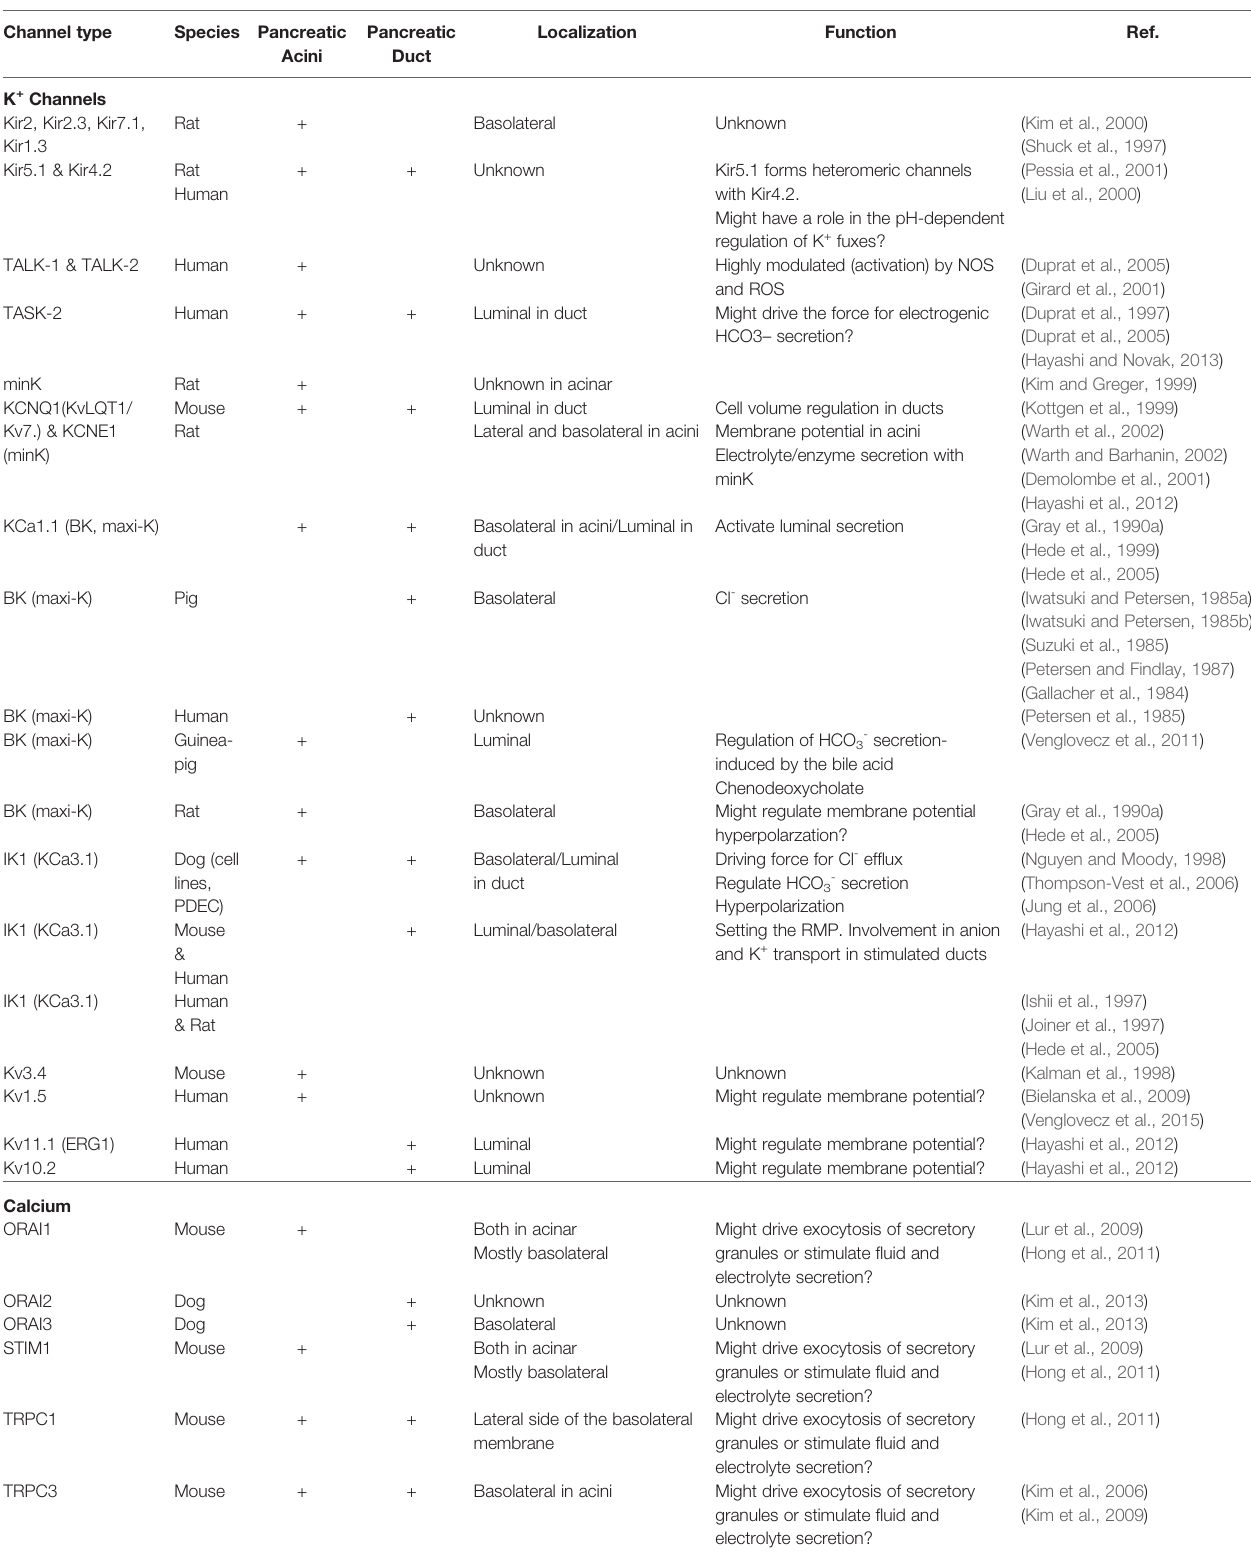
TABLE 1 | Expression, localization, and the potential role of ion channels in exocrine